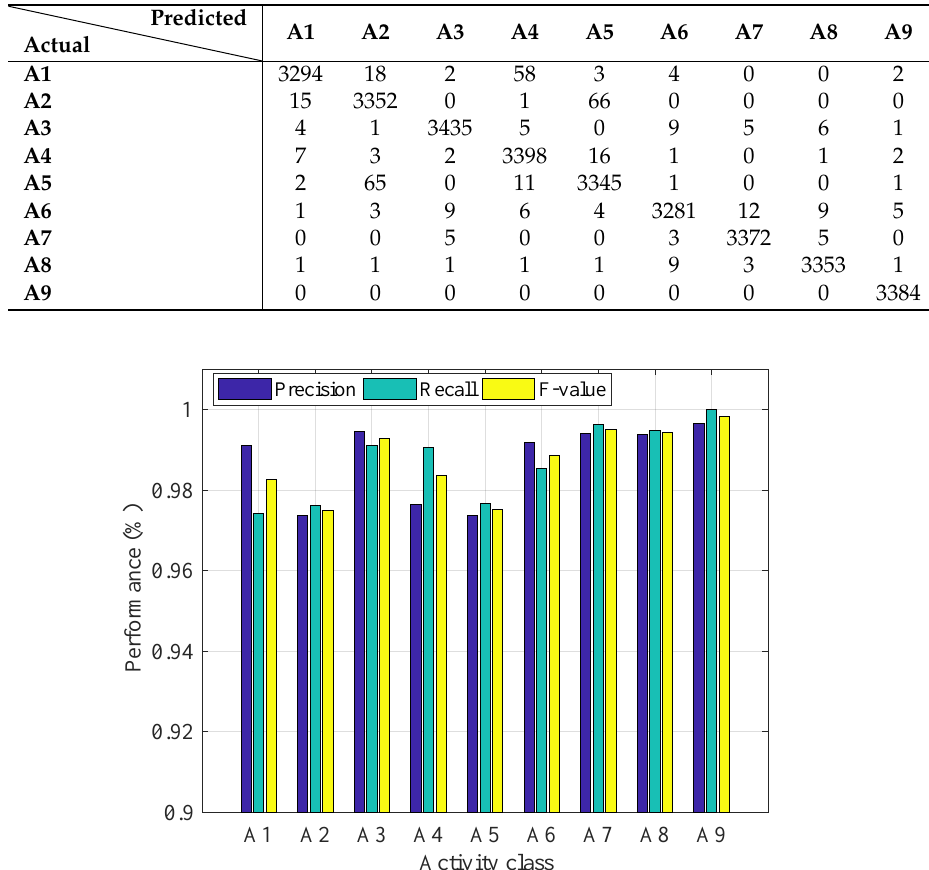
Table 5. The confusion matrix of the proposed method